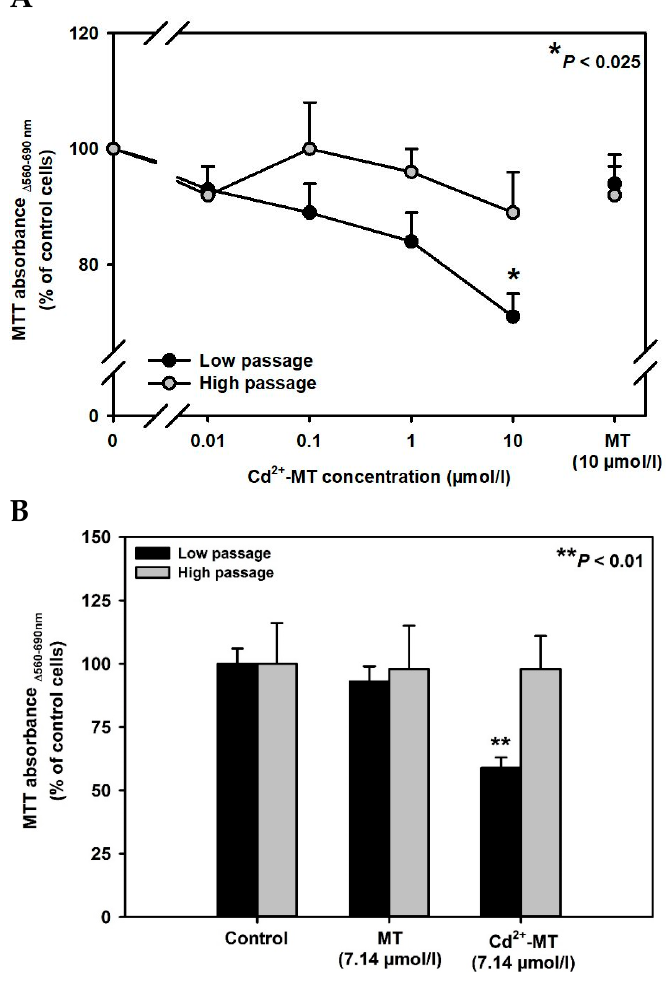
Figure 2. Low affinity of Cd 2+ -MT to megalin:cubilin in low passage WKPT-0293 Cl.2 cells. Treatments were performed in SFM mod , and cell viability was assessed using MTT assay. ( A ) Low and high passage cells were exposed to different concentrations of Cd 2+ -MT for 24 h. Means ± SEM of 8–11 experiments are shown. Absorbance values of control cells (modified serum-free medium only were 0.41 ± 0.16 a. u. ( n = 11) and 0.51 ± 0.19 a.u. ( n = 8)) for low and high passage cells, respectively, were set to 100%, and different Cd 2+ -MT concentrations were normalized accordingly. ( B ) Low and high passage cells were exposed to 7.14 µmol/L MT or Cd 2+ -MT ( ≅ 50 µmol/L for 24 h). Means ± SEM of 4–5 experiments are shown. Absorbance values of control cells were 1.06 ± 0.07 a.u. ( n = 5) and 0.86 ± 0.14 a.u. ( n = 4) for low and high passage cells, respectively, and set to 100%. Statistical analyses compared low to high passage cells by unpaired t -test.